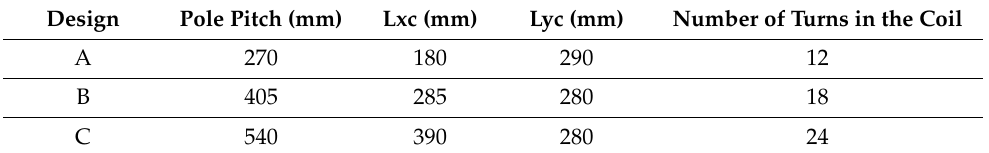
Figure 3. Design of levitation coil. Table 1. Design models of levitation coil.